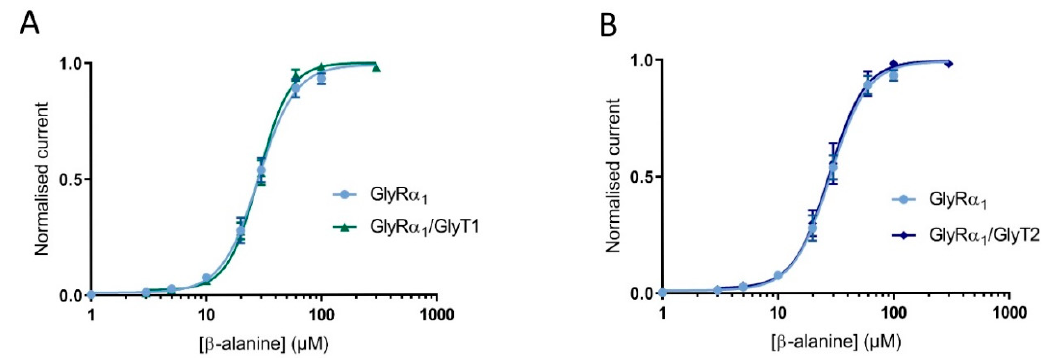
Figure 4. Reduction of stop-flow and fast-flow current amplitudes in co-expressed cells is dependent on GlyT transportable substrate. β -alanine dose-response curves in cells expression GlyR α 1 , GlyR α 1 / GlyT1 ( A ) or GlyR α 1 / GlyT2 ( B ) are superimposed, showing no shift in GlyR α 1 sensitivity when a non-substrate of GlyTs is used as an agonist for GlyR. Currents were normalised to I max and fit to the Hill equation. Symbols are mean ± SEM ( n ≥ 5).